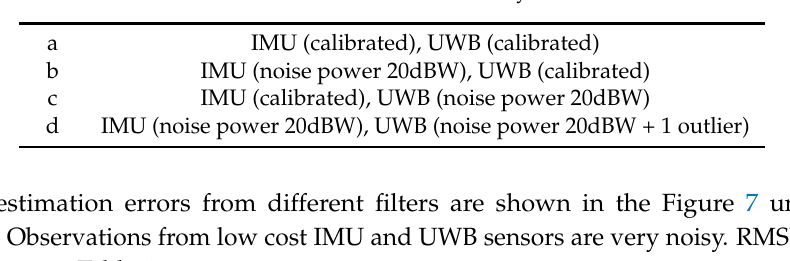
Table 5. Sensor observation study cases.